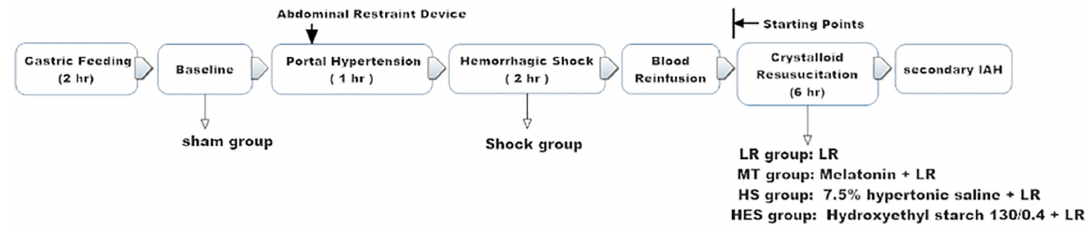
Fig 1. Schematic diagram of the experiment protocol. Rats were randomized into: sham group (sham, n = 8), no treatment was performed after anesthetization. Shock group (S,n = 8), no fluids were given after shock. Lactated Ringer solution (LR) group (LR, n = 8), after blood reinfusion, rats were resuscitated with LR (30 mL/h × 6hr). Melatonin group (MT, n = 8), after blood reinfusion, the rats were infused with melatonin (50mg/kg), then resuscitated with LR (30 mL/h × 6hr). Hypertonic saline group (HS, n = 8), after blood reinfusion, rats were infused with 7.5% hypertonic saline (6ml/kg), then resuscitated with LR (30 mL/h × 6hr). Hydroxyethyl starch group (HES, n = 8), after blood reinfusion, rats were infused with hydroxyethyl starch 130/ 0.4 (30ml/kg), then resuscitated with LR (30 mL/h × 6hr). The IVCP after blood reinfusion was set as the starting point, and the secondary IAH was determined by an elevation of 12.5 mmHg (170 mmH2O) of IVCP from the starting point.